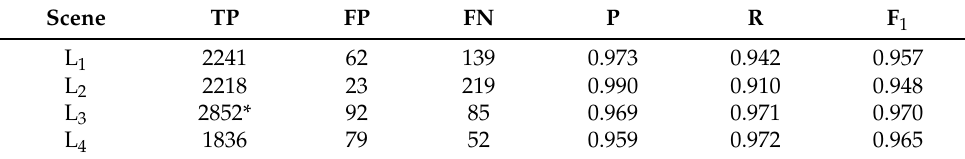
Table 3. Evaluation of the proposed system using videos captured at different